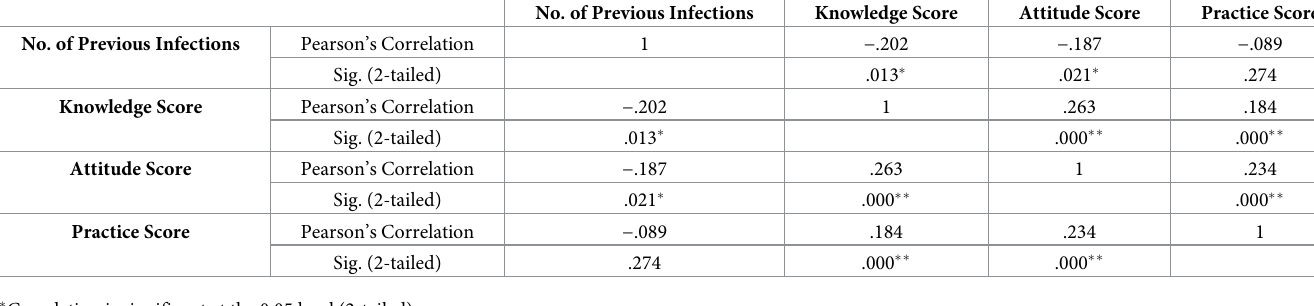
Table 5. Correlation between scores for frequency of infections, knowledge, attitude, and practice.